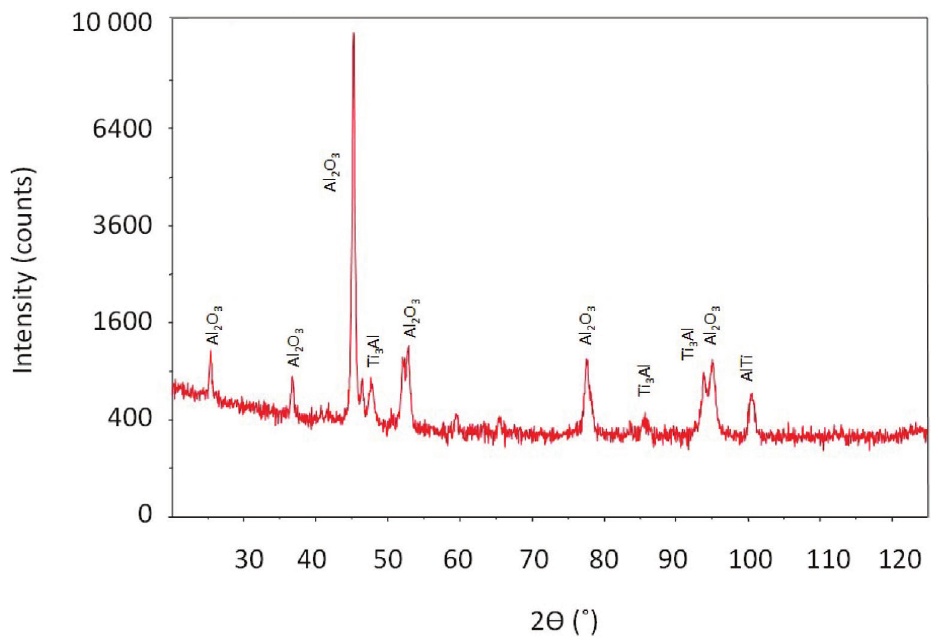
Fig. 3: XRD microanalysis result of Ti-46Al-7Nb-0.7Cr-0.1Si-0.2Ni alloy coated with Al 2 O